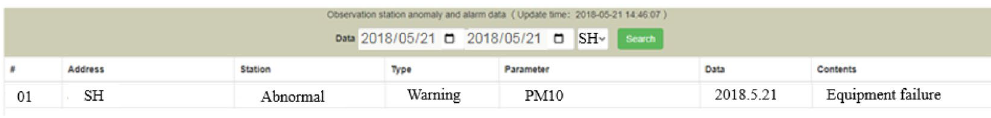
Figure 4. The platform early warning module includes data acquisition anomalies and data threshold